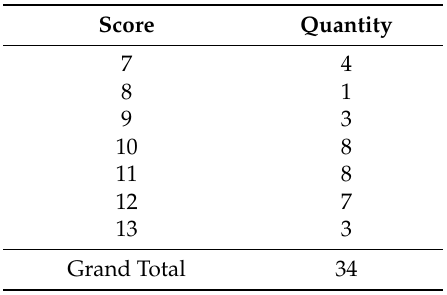
Table 5. Distribution of papers for different